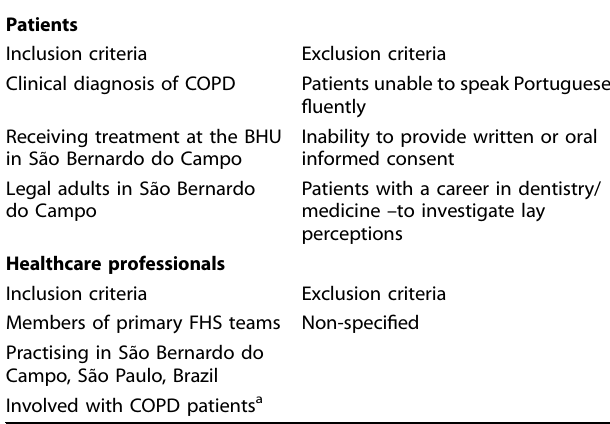
Table 4. Eligibility criteria for participant